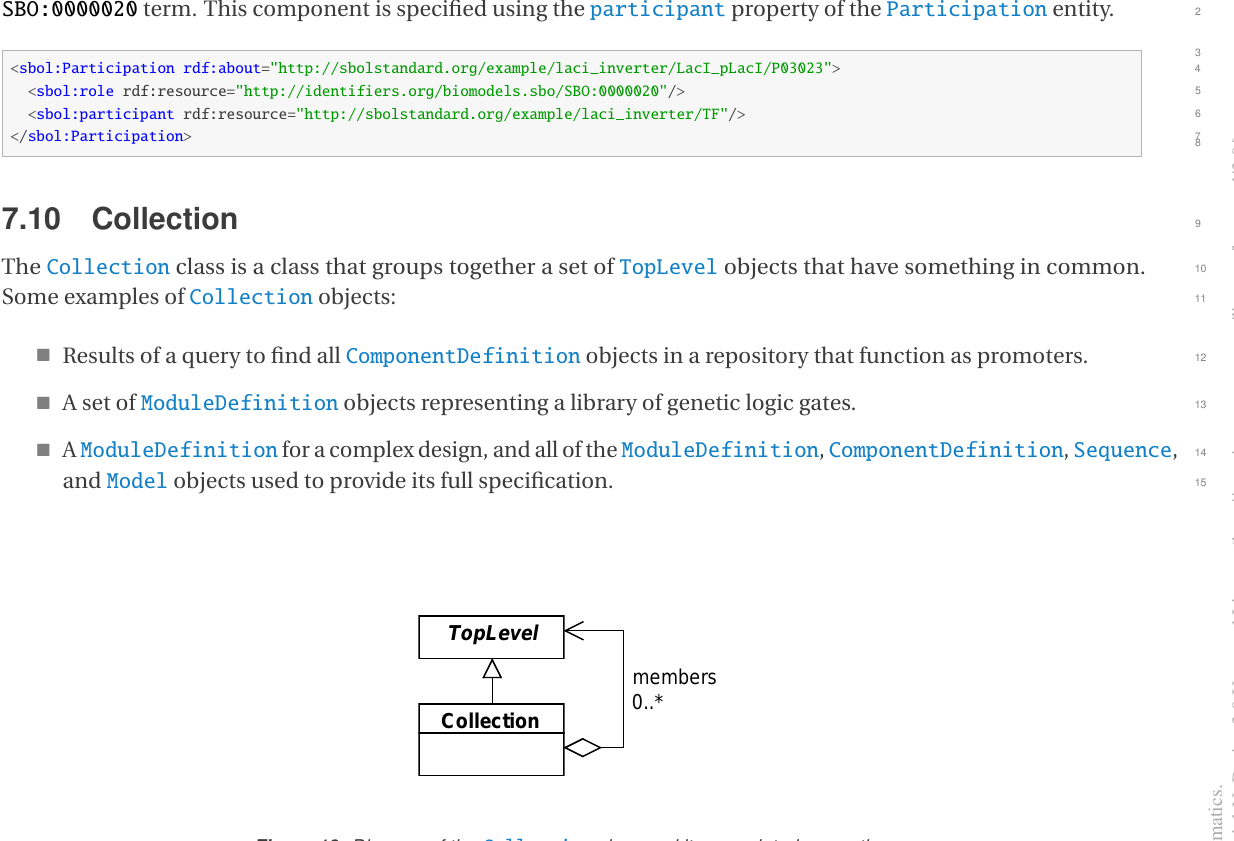
Figure 19: Diagram of the Collection class and its associated